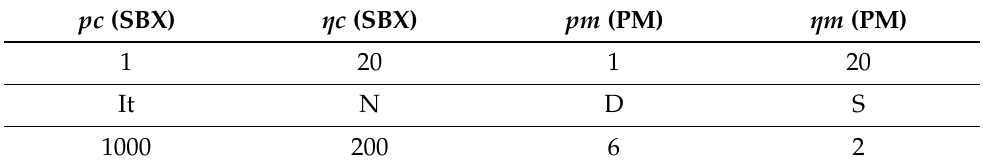
Table 1. Settings of the algorithm